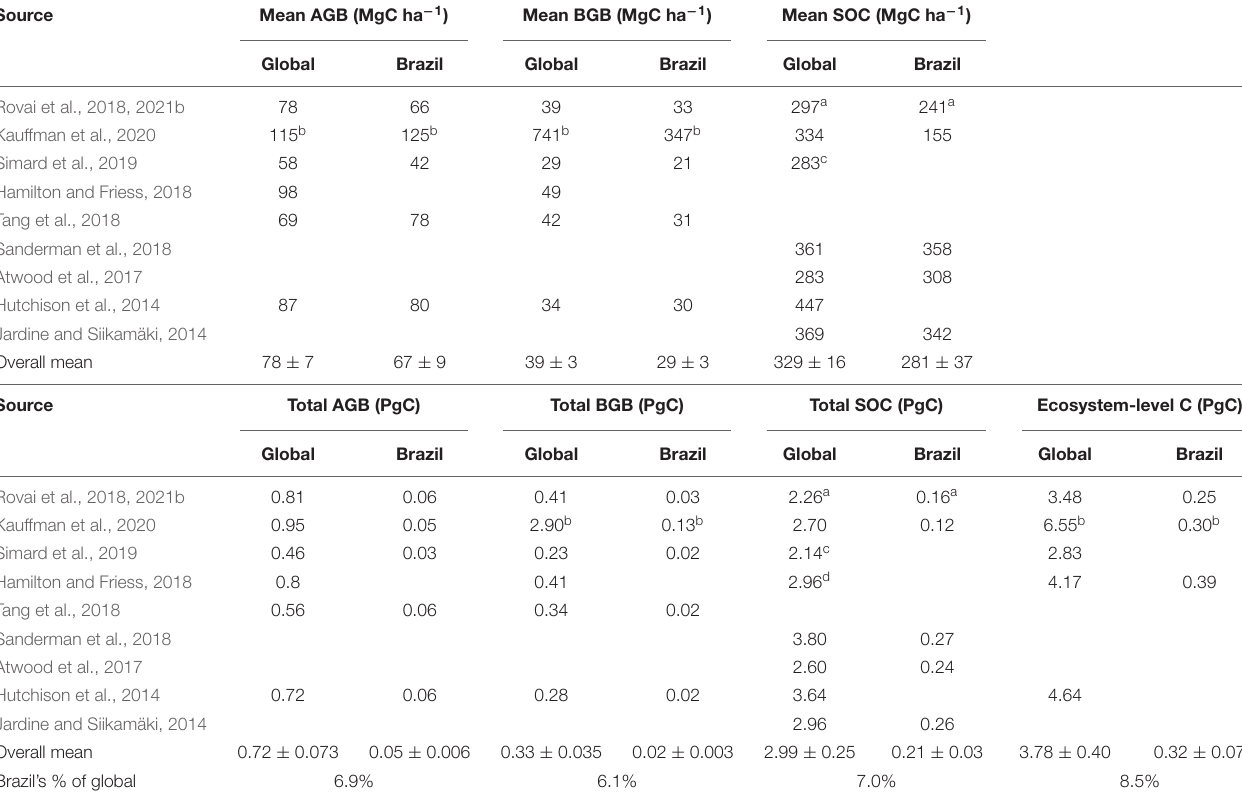
TABLE 1 | Published above- and belowground biomass (AGB and BGB), and soil organic carbon (SOC) stock estimates for global and Brazilian mangroves.